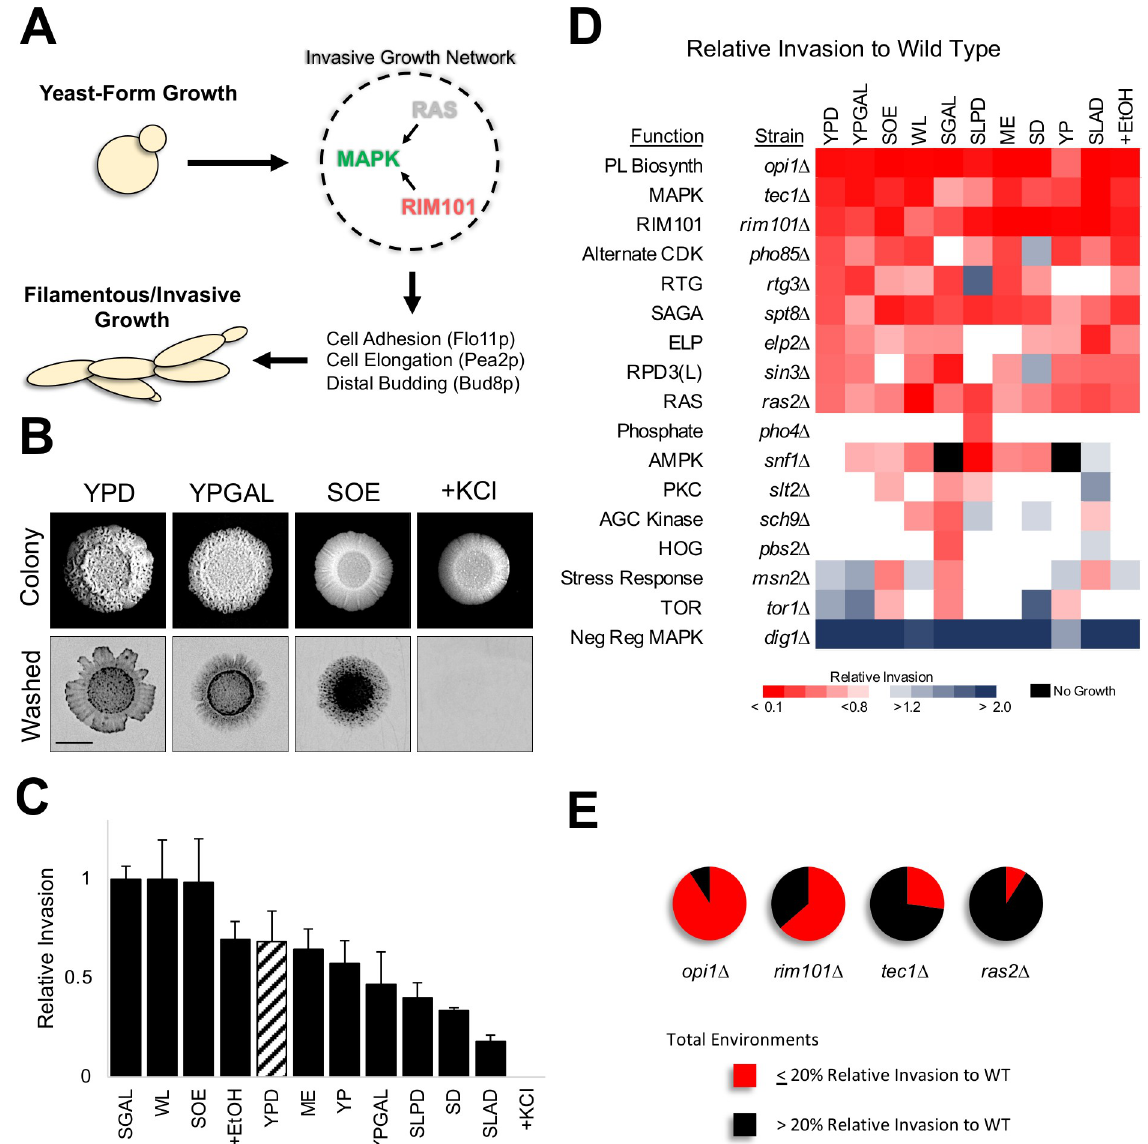
Fig 1. The regulation of invasive growth varies across environments. A) Yeast invasive/filamentous growth is regulated by pathways in a network (several major pathways are shown here), that can regulate each others’ activity, and that regulate changes into the new cell type. B) PWA. Colony, cells before wash; Washed, invasive scars after wash, bar, 0.5 cm, inverted images are shown. C) Relative levels of invasive growth (values set to 1 for SGAL). Standard laboratory medium (YPD), diagonal lines. D) Heat map of relative invasion of network mutants compared to wild type by PWA. Vertical axis, strain. Horizontal axis, environments. White, same invasion as wild type, blue, more invasion, red, less invasion. Black, no growth. Raw data is shown in S1 Fig ; Bar graphs with standard deviation in S2 Fig ; and statistical tests that show significance of pairwise comparisons in S1–S3 File . The filamentous growth network includes: OPI1 ; MAPK ; RIM101 ; RAS ; Pho85p [alternate cyclin-dependent kinase (CDK)]; RTG (retrograde); PKC [Protein Kinase C pathway, regulates cell-wall integrity [226–228], and invasive growth [229]]; AMPK Snf1p, which derepresses the expression of enzymes that metabolize non-fermentable sugars [230–232] and positively regulates invasive growth [66]; Pho4p , a part of the phosphate regulon that responds to phosphate limitation [233–235]; Msn2p , a transcription factor involved in stress responses in yeast [236–238]; HOG (high-osmolarity glycerol), responds to high-osmolarity stress [71,72,239]; TOR ( target of rapamycin), a highly conserved pathway in eukaryotes that regulates cell metabolism/growth/proliferation/ survival [240–243], invasive growth [244], and the AGC kinase , Sch9p [245]; ELP [the elongator complex [246–248], involved in regulating invasive growth [249]]; the chromatin-remodeling complex Rpd3p(L) [82,250],involved in regulating invasive growth [88]; and the chromatin-remodeling complex SAGA [Spt-Ada-Gcn5 acetyltransferase [251–253], involved in regulating invasive growth [86]]. E) Ranking of the main pathways was based on invasive growth compared to wild type ( S3 Fig ). The number of environments a mutant showed � 20% (red) or > 20% (black) of wild-type invasion are shown.